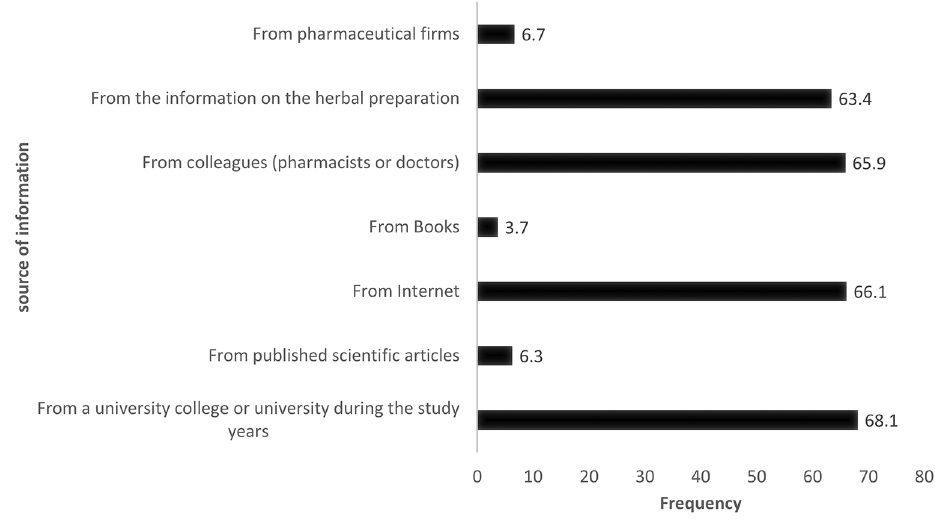
Figure 2. Source of information about herbal products.